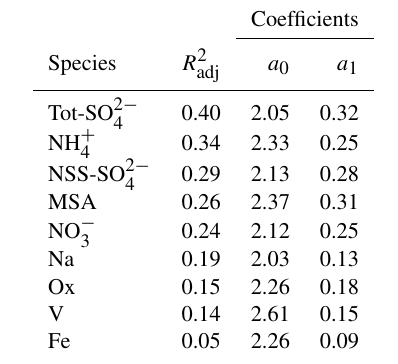
Table 3. Summary of one-predictor models for N d based on using any of nine of the final chemical species that were identified after applying the filtering scheme shown in Fig. 2. The coefficients cor- respond to a linear model of the form log( N d ) = a 0 + a 1 log( M i ), where M i is the mass concentration of species i